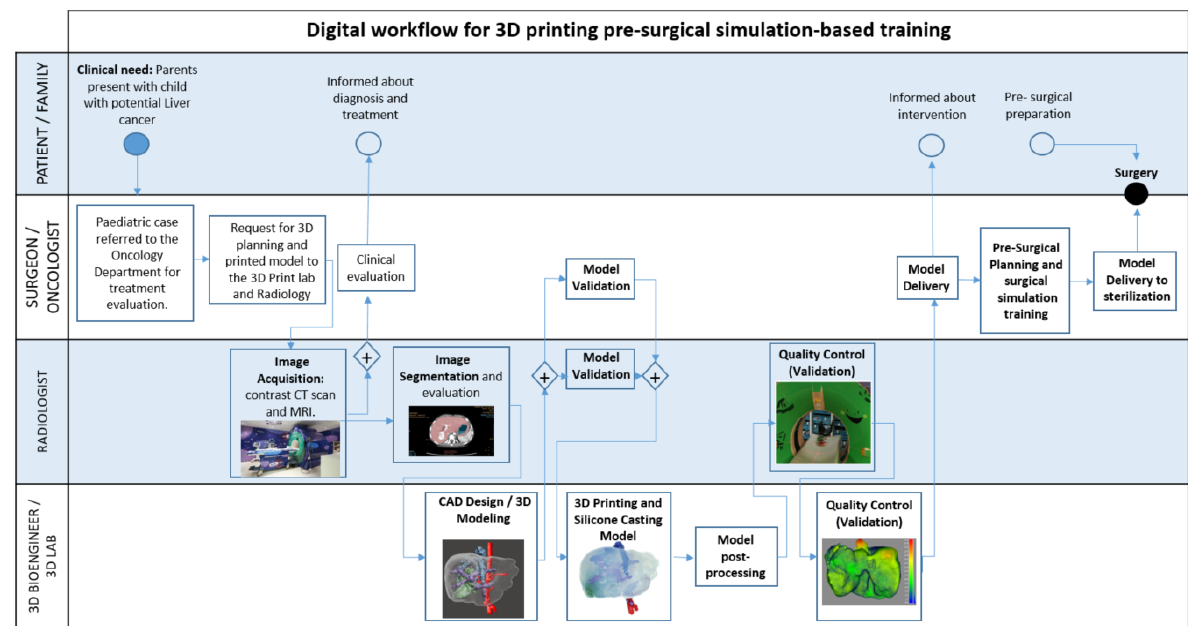
Figure 4. Process flowchart representation of the digital workflow for 3D printing pre-surgical simulation-based training.